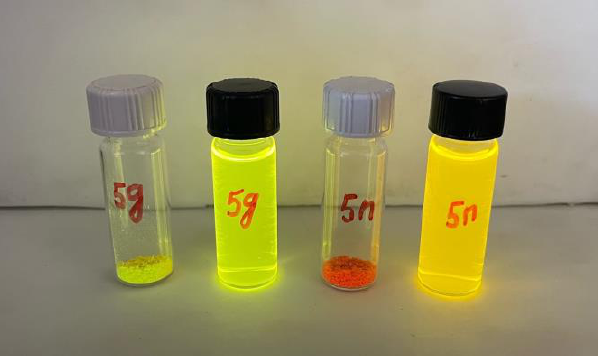
Figure 10. Fluorescence of compounds 5g and 5n in solid state and in MeCN solution under 365 nm UV lamp.